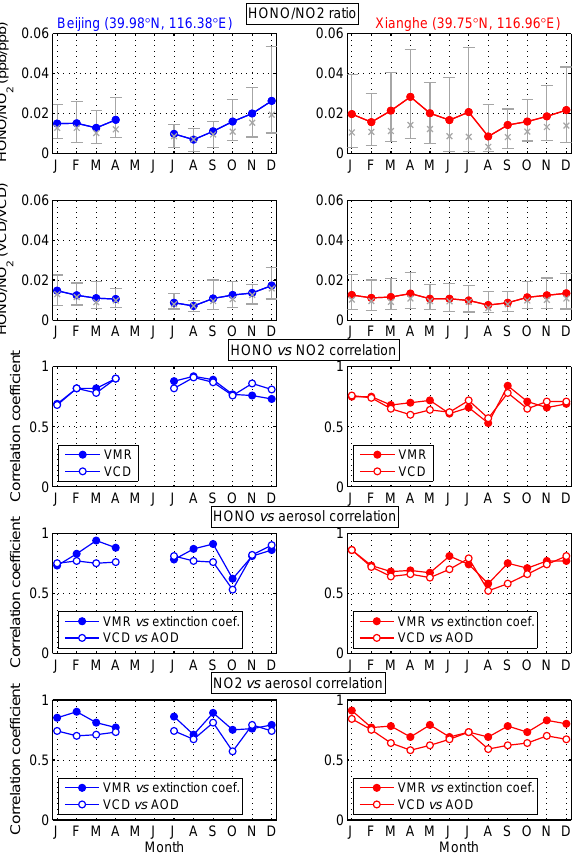
Fig. 8. Seasonal variation of the HONO and NO 2 surface concen- tration and vertical column density (VCD) and AOD at 360nm at Beijing (left plots) and Xianghe (right plots). Data correspond to monthly averages over the time interval of ± 2h around local noon. The cross symbol and the lower (upper) error bars represent the me- dian and the 10th (90th) percentiles of the data, respectively.